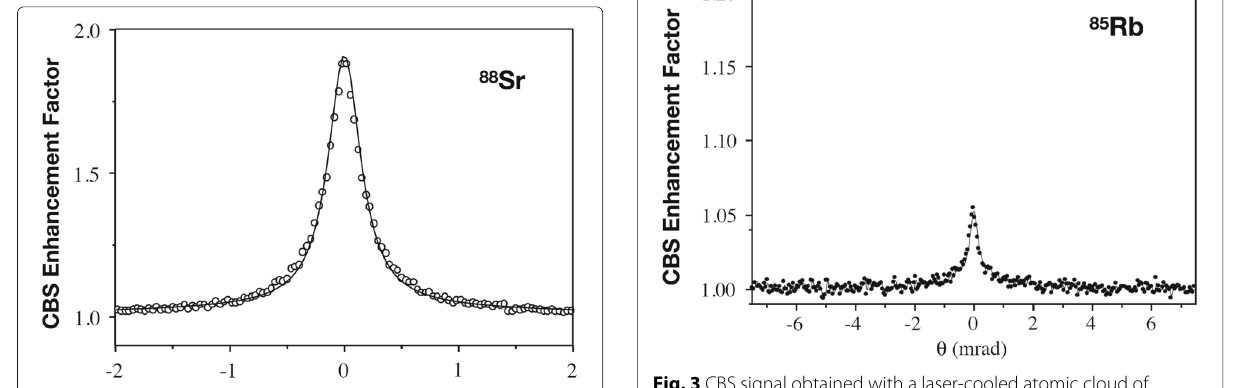
Fig. 3 CBS signal obtained with a laser-cooled atomic cloud of Rubidium atoms ( 85 Rb) in the helicity-preserving channel, see [37, 41]. Since this atom possesses a non-zero spin in its ground state, the reciprocity relation Eq. (85) cannot be fulfilled at exact